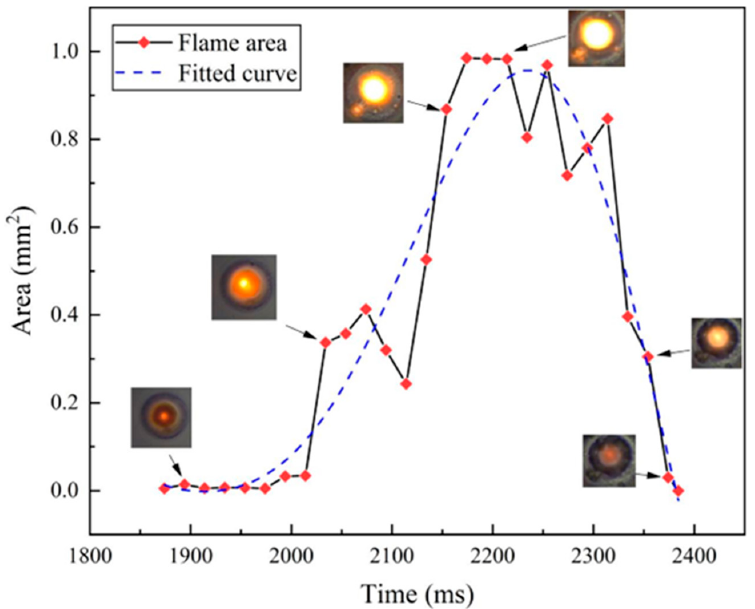
Figure 9. Flame propagation and areas denoting of a single burned Al-Li alloy microparticle.